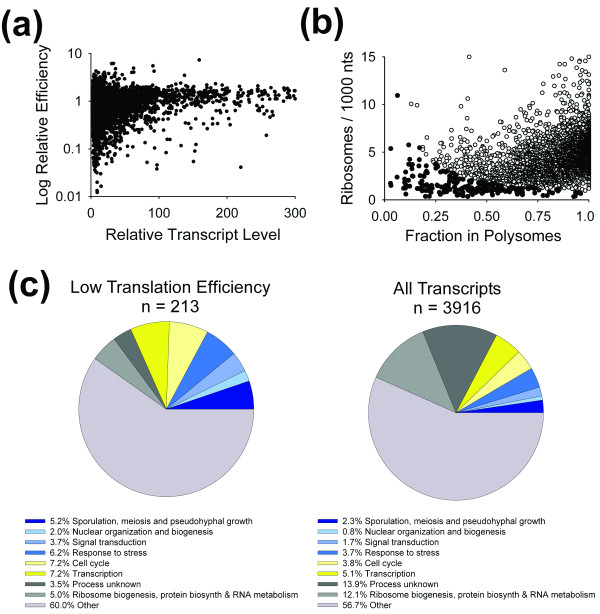
The under-translated transcripts of Saccharomyces cerevisiae. (a) Translational efficiency across the transcriptome. Translation state array data from exponentially growing yeast were used for 3916 transcripts with open reading frames (ORFs) longer than 400 nucleotides and whose distributions after sucrose gradient centrifugation could be modeled reliably [3]. To calculate translational efficiency, the fraction of each transcript in polysomes was multiplied by the mean ribosome density, expressed as ribosomes per 1,000 nucleotides of ORF, and these values were normalized to a mean of 1.0. Translational efficiencies are plotted on a logarithmic scale versus relative transcript level obtained from the array analysis [3]. (b) Ribosome loading on the transcriptome of steady-state growing yeast. Ribosome density (ribosomes per 1,000 nucleotides) is plotted against the fraction of each transcript in polysomes. The data are those used to calculate the translational efficiencies in (a). The under-translated transcripts (<0.25 of the mean translation efficiency) are represented by the filled symbols and the remaining transcripts by the open symbols. (c) Gene ontology (GO) analysis of the under-translated transcriptome. The frequency of biologic process catagories appearing in the indicated populations was analyzed, as described in the text, using the GO tools associated with the Saccharomyces Genome Database [66].